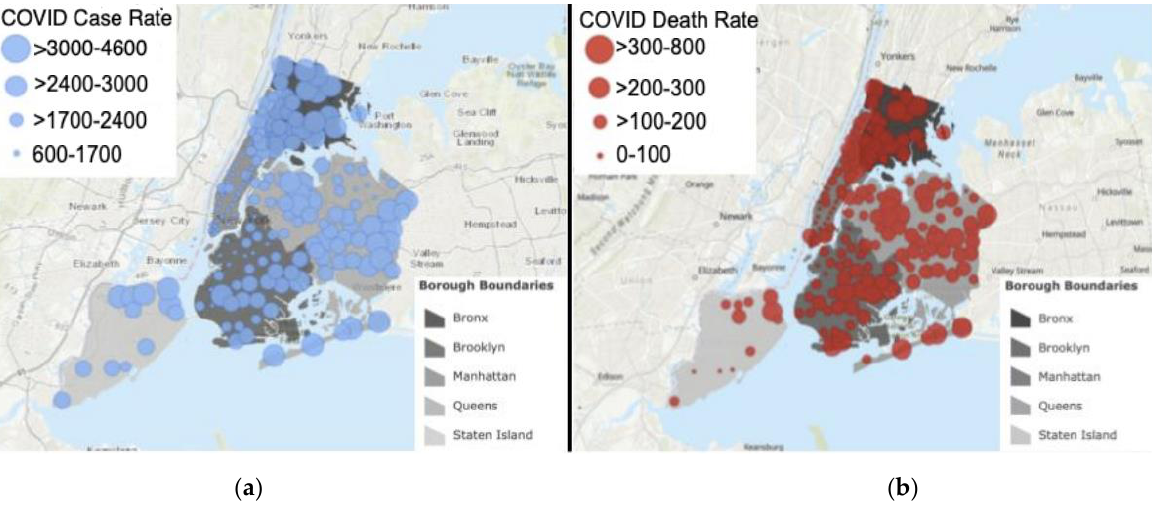
Figure 3. ( a ) Map of COVID-19 case rate (per 100,000 residents) in New York City per zip code with shaded borough boundaries; ( b ) Map of COVID-19 death rate (per 100,000 residents) in New York City per zip code with shaded borough boundaries.